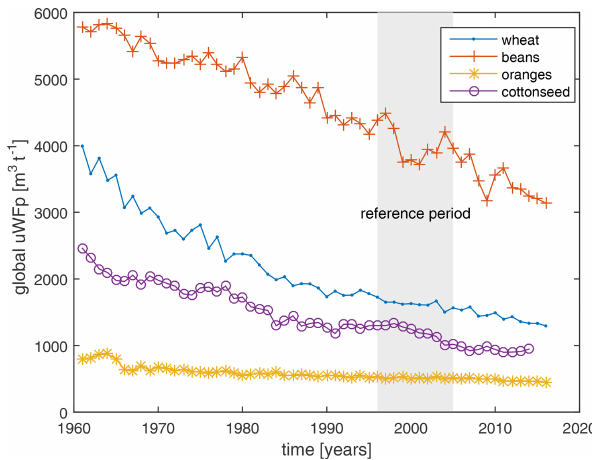
Figure 3. Production-weighted global uWFp along the period 1961–2016 for wheat, beans, oranges, and